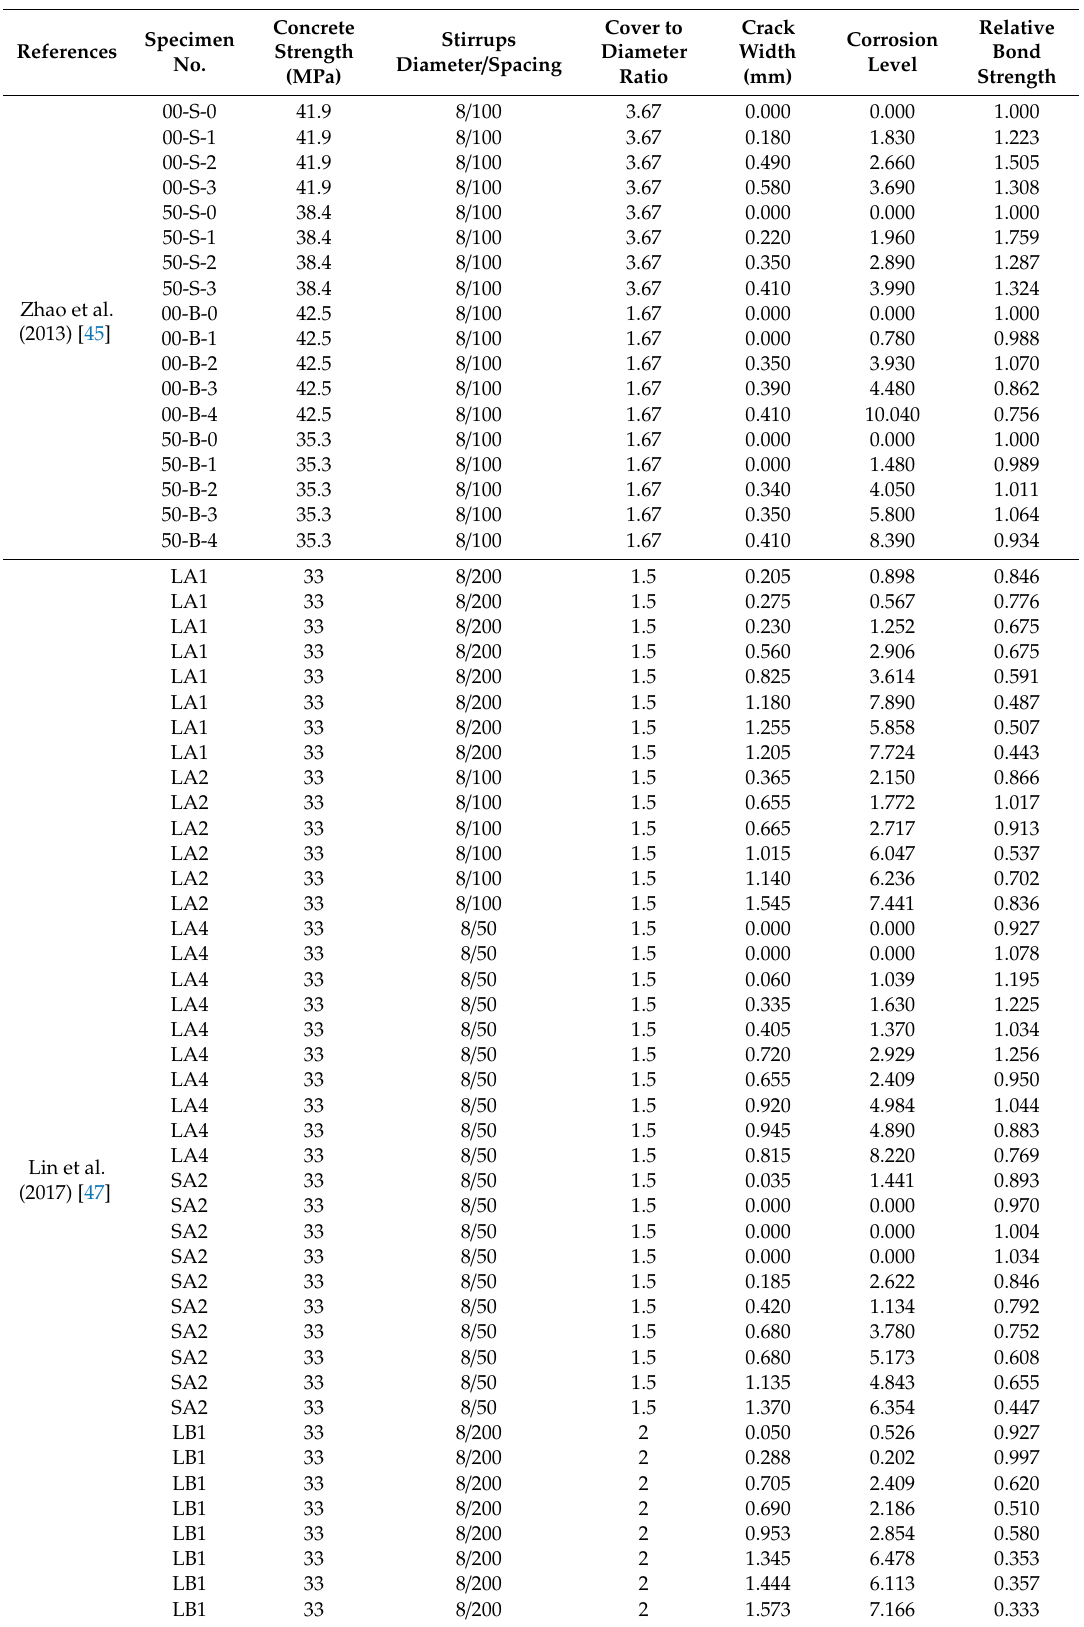
Table A4. Dataset for cases with stirrups and variables including corrosion level ( n =